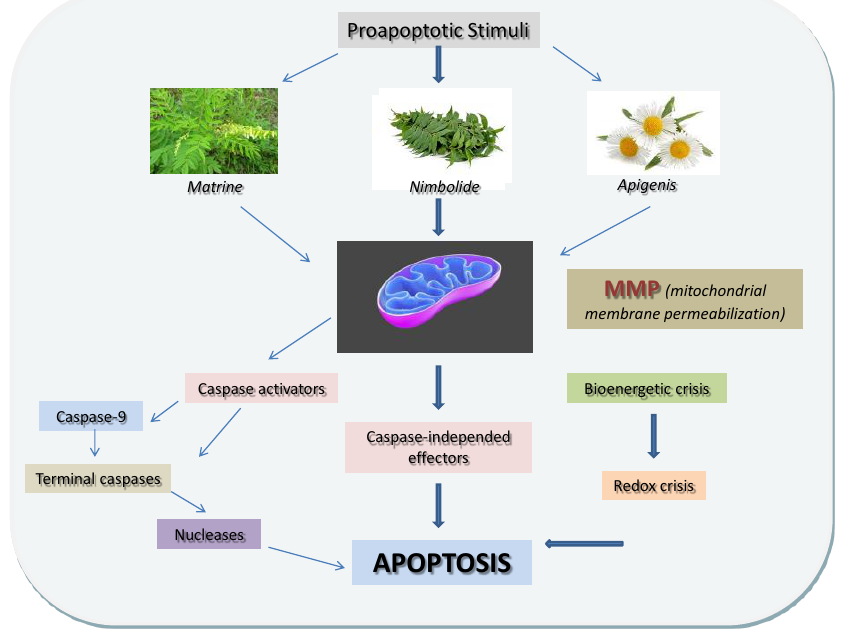
Figure 7. Induction of mitochondrial (“Intrinsic”) pathway of apoptosis induced by various herbal and plant proapoptotic stimuli. The proapoptotic stimuli derived from various plants and herbals (Matrine, Apigenis, Nimbolide, Curcumocin, Lupeol, etc.) initiate this pathway by inducing permeability of MMP (mitochondrial membrane permeabilization). Subsequently, intermembrane space proteins are released into the cytosol, and the mitochondrial transmembrane potential is dissipated, causing, as a result, the induction of bioenergetic and redox crises, leading to the activation of both caspase-dependent and -independent mechanisms, committing the cell to death.